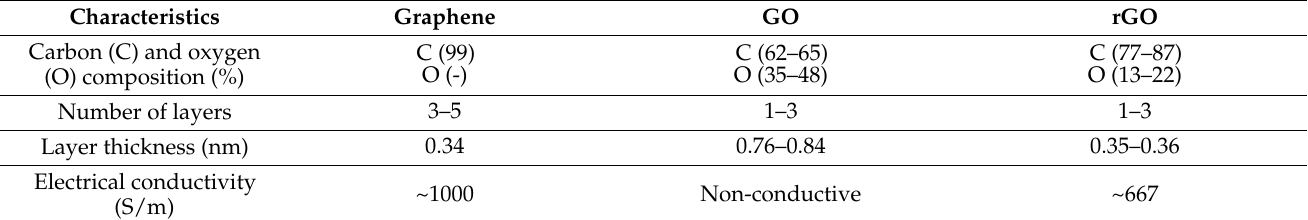
Table 2. The characteristics of graphene, GO, and rGO as gas sensors and their